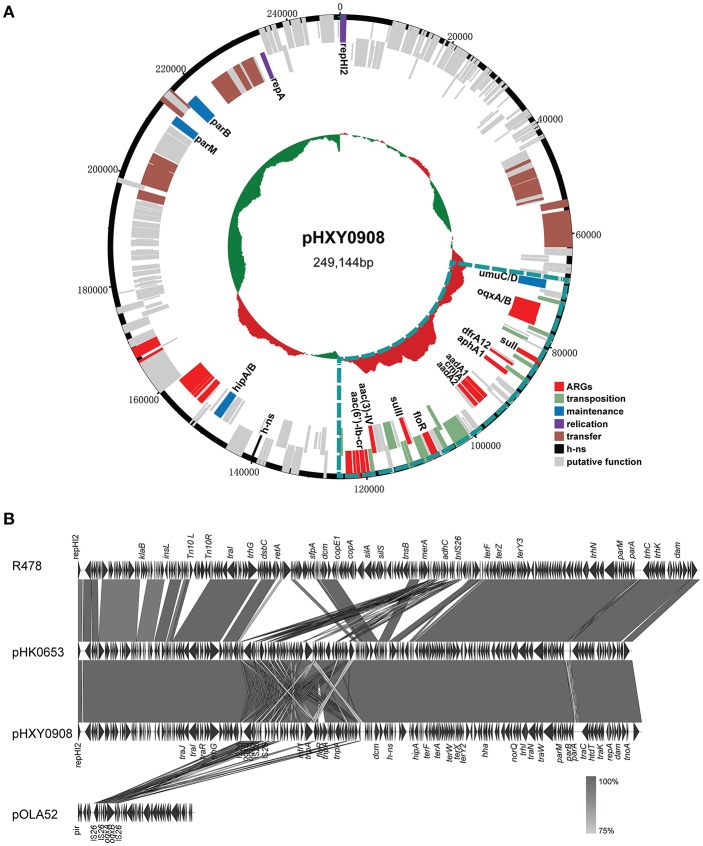
Genetic map and linear comparisons for pHXY0908. (A) Genetic map of pHXY0908. The central region of the map is G+C plot of the nucleotide sequence. Boxes represent ORFs predicted with RAST tools and are color coded after their predicted functions. The blue lines represent the multidrug-resistant regions. (B) Linear comparison of pHXY0908, R478, pHK0653, and oqxAB-positive plasmid pOLA52. The arrows represent ORF position and transcriptional direction. Regions of homology are shaded in gray and functional regions are indicated above and below the linear maps.